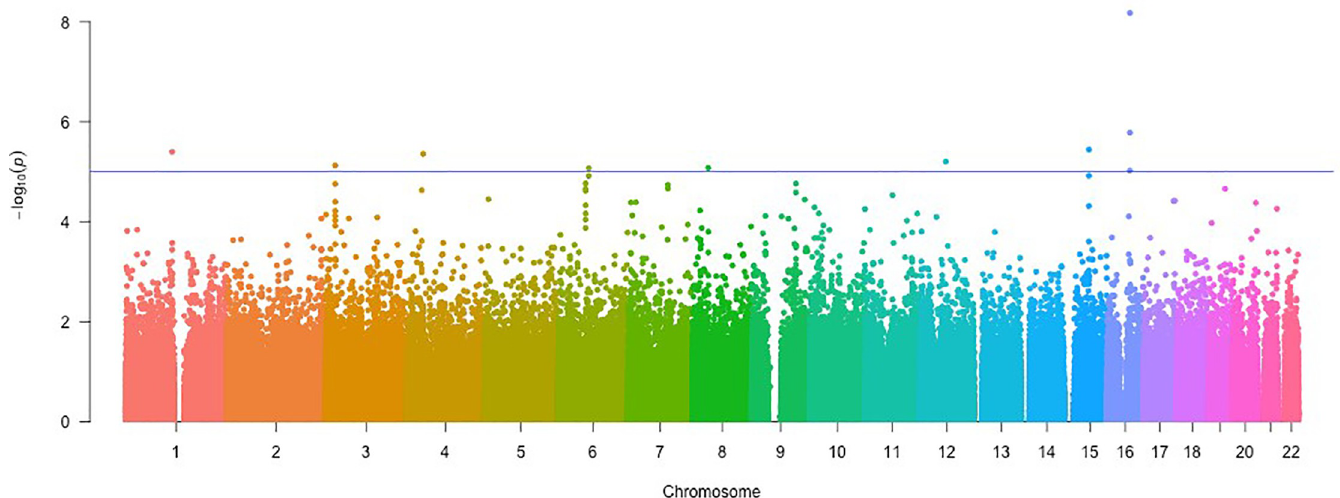
Fig 1. Manhattan plot of results from adjusted GWA analysis: P -values reported are from the model adjusted for biological variables. Y-axis is shows the significance (-log 10 p-value) of each association. X-axis is split by chromosome and ordered by position in base pairs. A total of 307,238 SNPs were tested in an association analysis of 2,700 Lebanese individuals. Line at suggestive significance cutoff (1x10 -5 ).